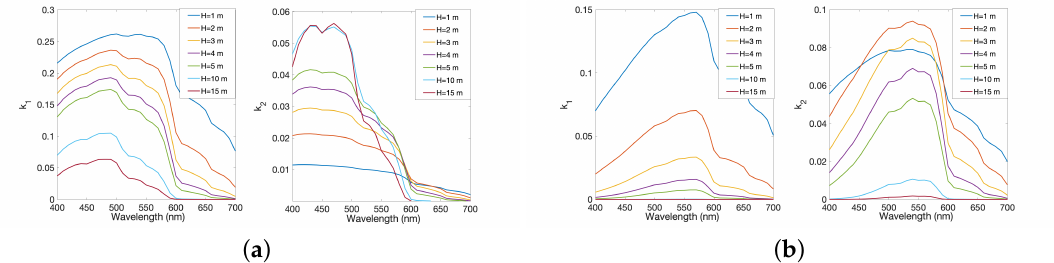
Figure 2. Direct and diffuse water column attenuation (respectively k 1 and k 2 vectors); ( a ) Clear water ( Chl = 0.03 mg · m − 3 , SM = 0.01 mg · L − 1 , CDOM = 0.01 m − 1 ); ( b ) Moderately turbid water ( Chl = 1 mg · m − 3 , SM = 1 mg · L − 1 , CDOM = 0.1 m − 1